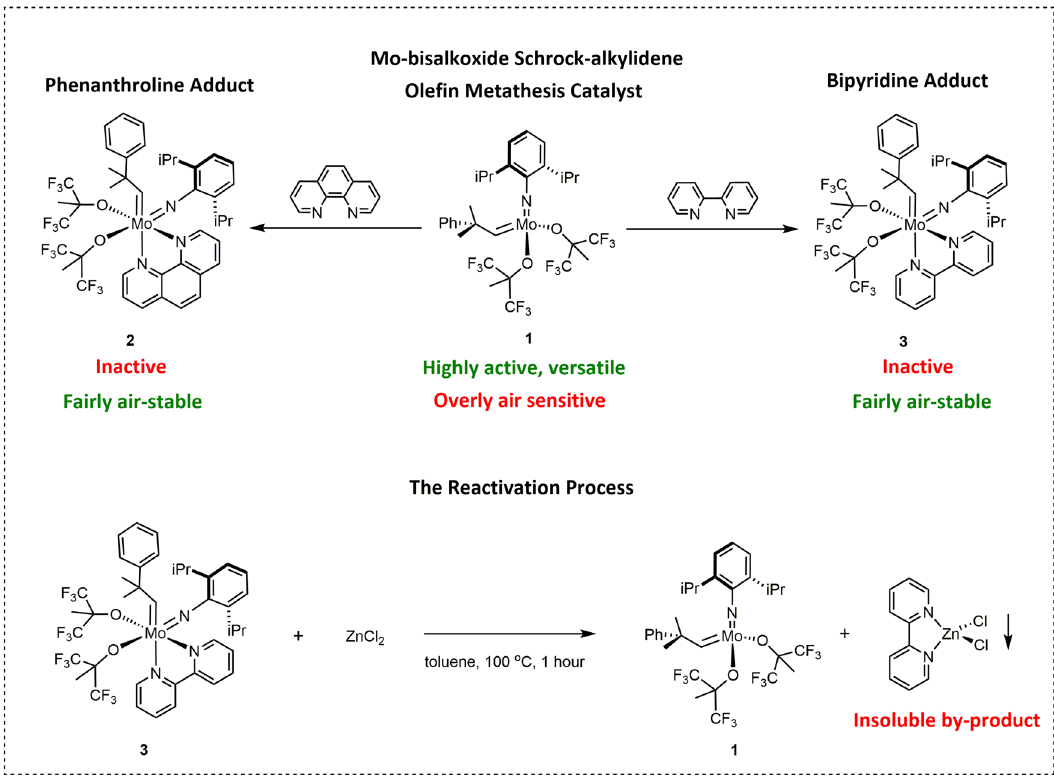
Fig. 1 Fürstner ’ s approach towards air-stable 18-electron adducts of Mo-bisalkoxide Schrock alkylidenes 17 . The Mo-bisalkoxide Schrock alkylidene [Mo (NAr diiPr )(neophylidene)(OCMe(CF 3 ) 2 ) 2 ] ( 1 ) readily and irreversibly reacts with both 1,10-phenanthroline and 2,2 ′ -bipyridine, yielding the air-stable but inactive 18-electron adducts 2 and 3 ; the active catalyst 1 can be liberated from 2 and 3 via a high-temperature treatment with appropriate Lewis